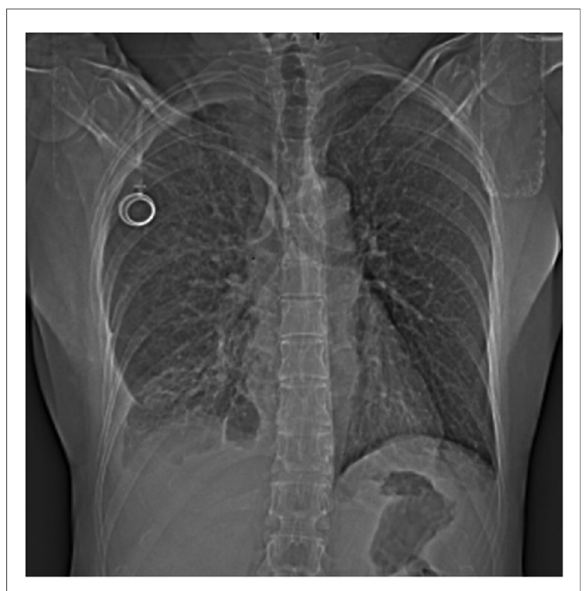
FIGURE 1 Chest x-ray showing a large right pleural effusion with abnormal position of the distal tip of the